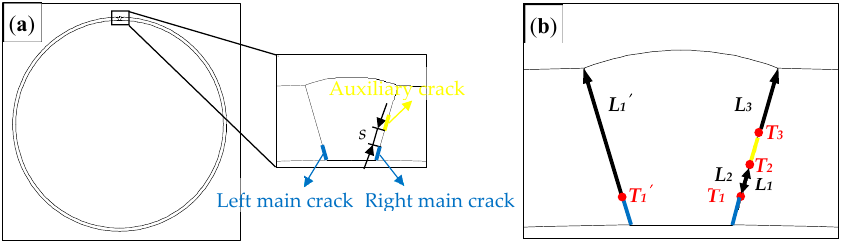
Figure 1. Schematic diagram of the pipeline weld model with prefabricated cracks. ( a ) Location of main crack and auxiliary crack, ( b ) crack tip and path